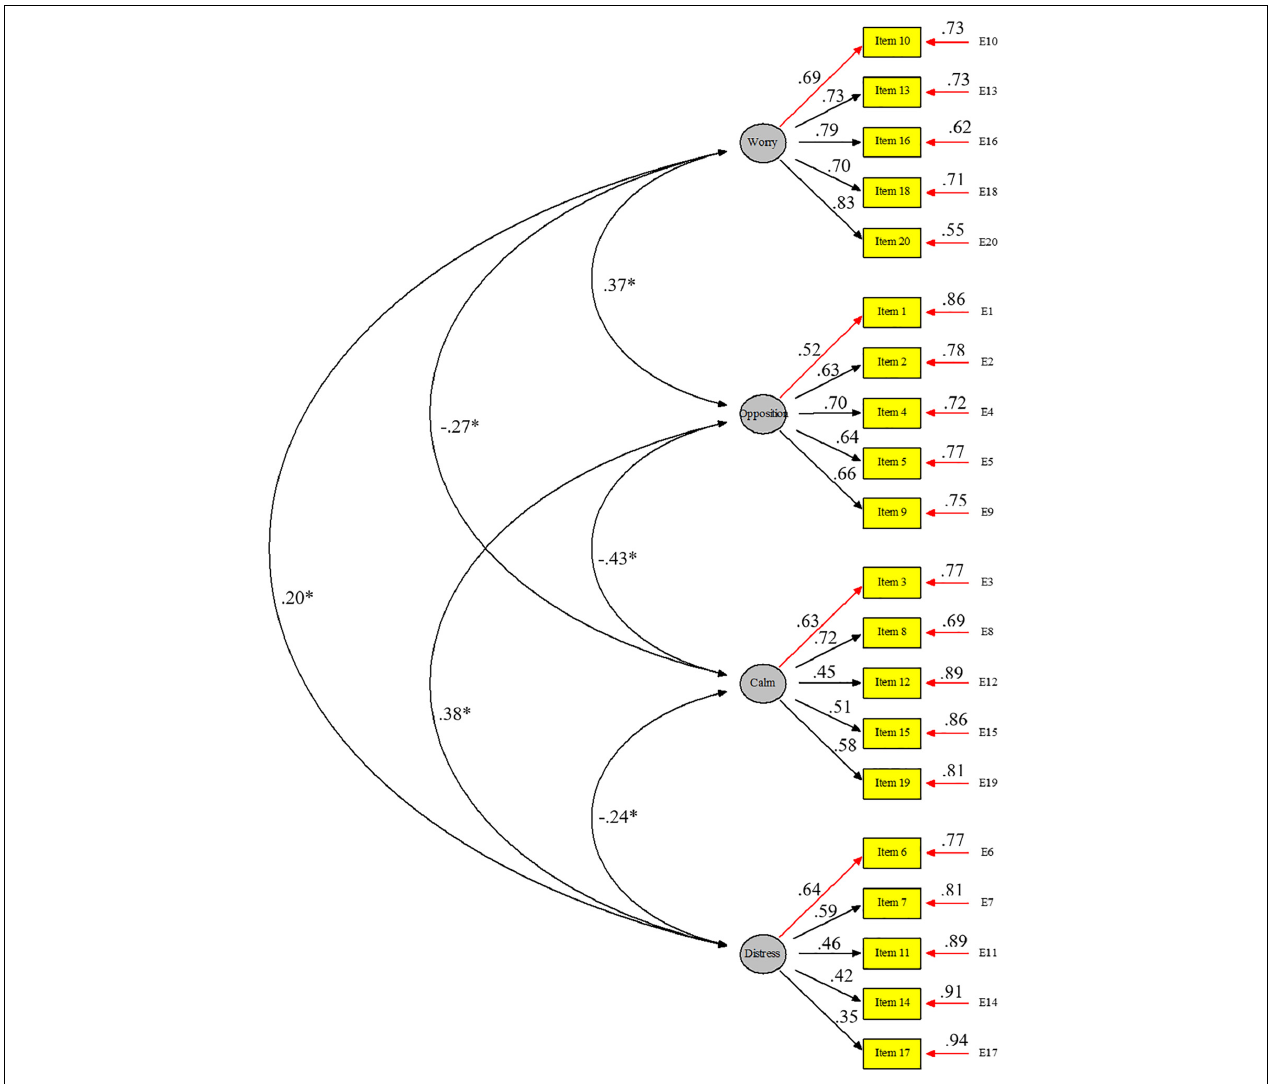
FIGURE 2 | Graphic representation of the 4-factor model of the CSAS-P.